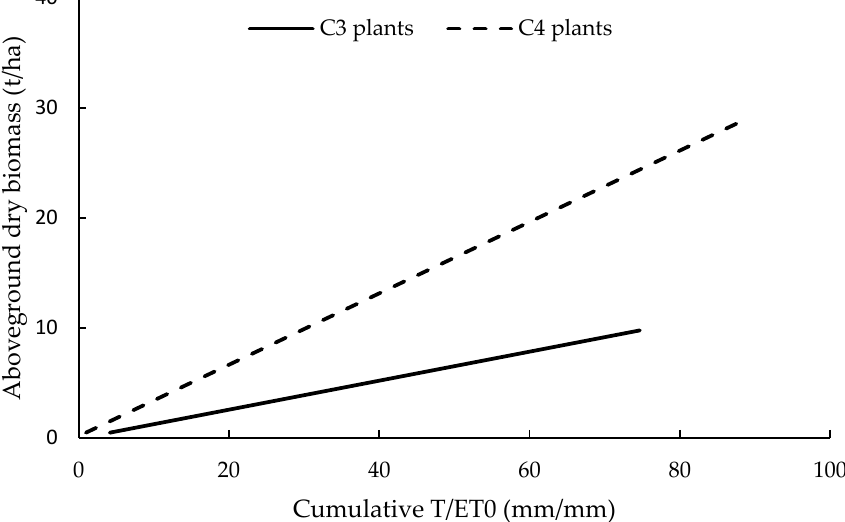
Figure 2. Relationship between above ground biomass and cumulative transpiration normalized by ET0 in AQUACROP (FAO-66 approach, redrawn from Steduto et al. [88]). The approach is based on Tanner–Sinclair [93] biomass-transpiration relationship. The two lines indicate the carbon fixation type: the C4 plants line is based on sorghum, the C3 plants line on sunflower, wheat and chickpea.